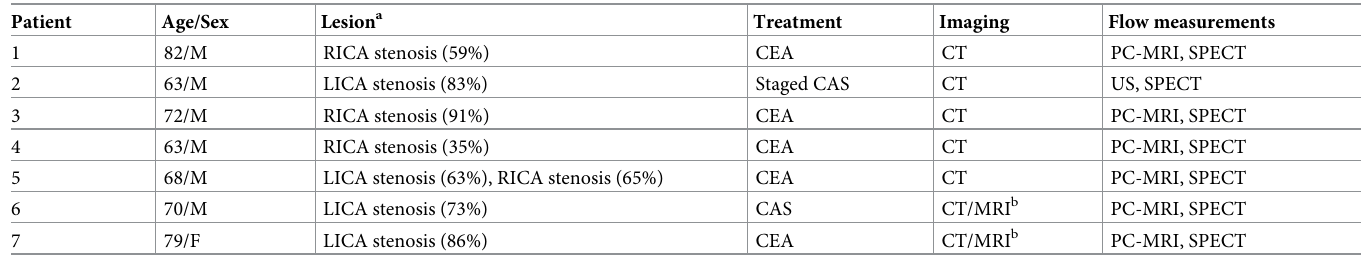
Table 1. Patient characteristics.